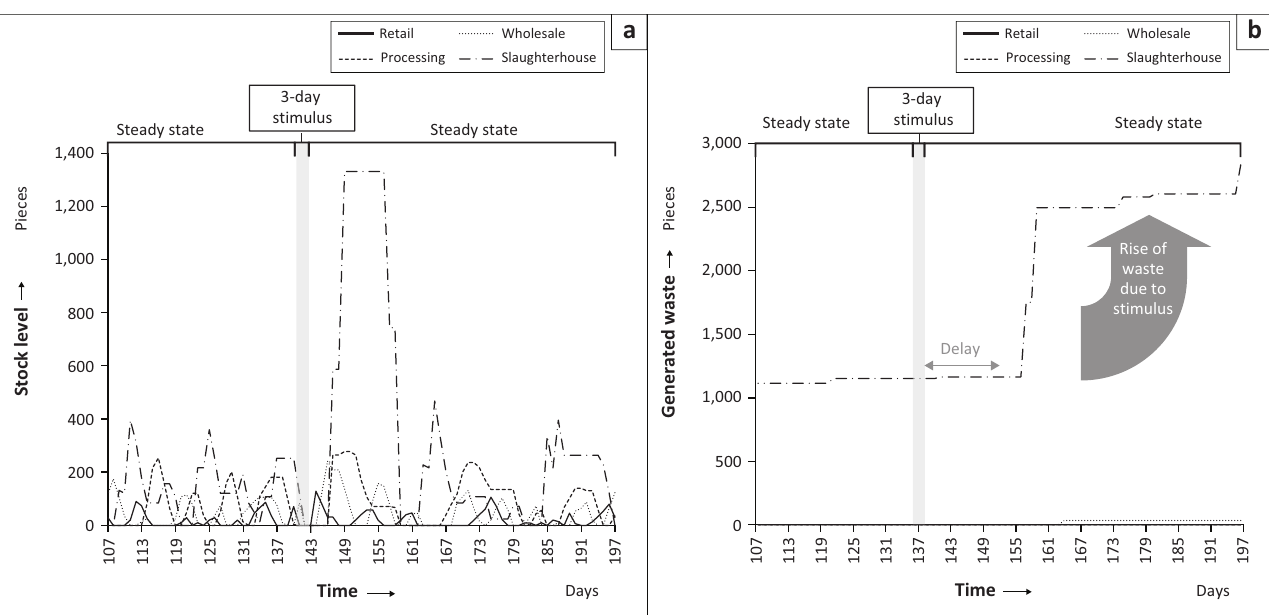
FIGURE 3: Development of (a) stock levels and (b) generated waste before and after a 3-day sinusoidal stimulus.